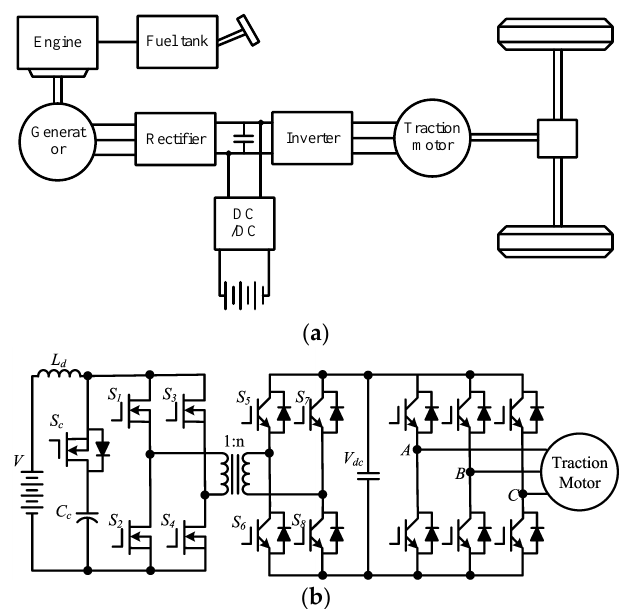
Figure 1. Energy conversion system in series HEV with bidirectional DC/DC converter: ( a ) system configuration; ( b ) DAB converter.